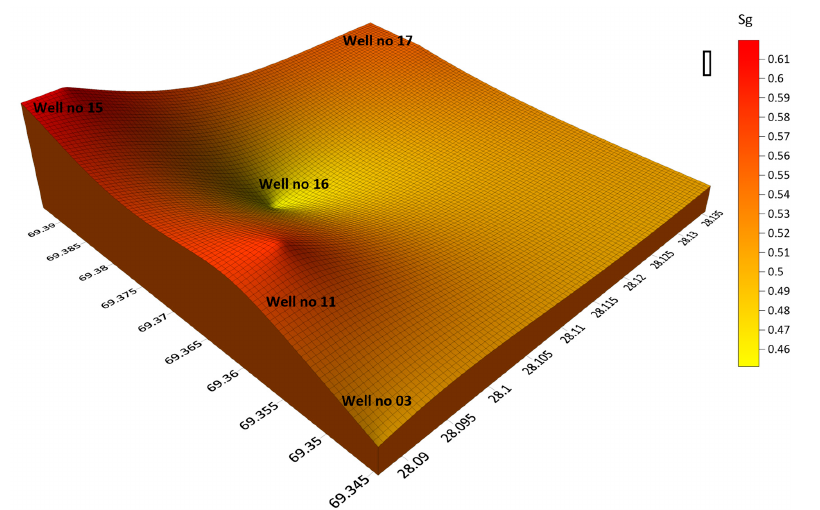
Figure 14. Water saturation (Sw) variation map computed in (%).